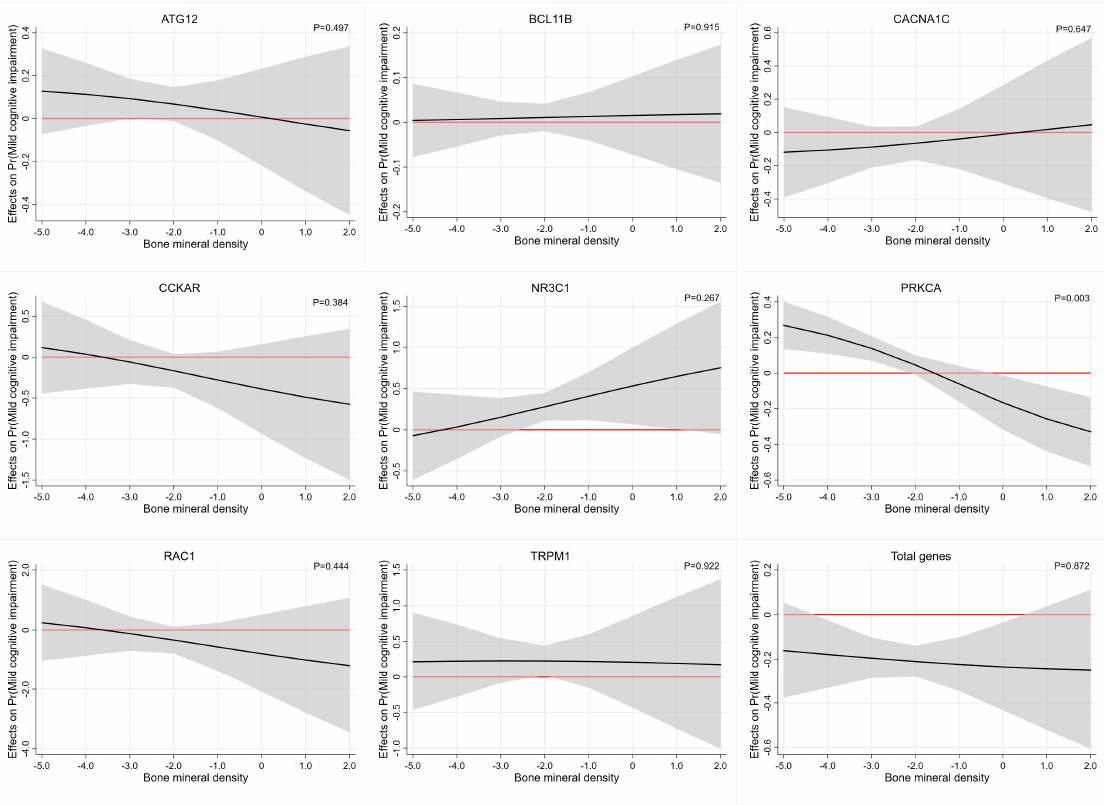
Figure 1. The average marginal effect of the PRS across the BMD range. Each subgraph represents